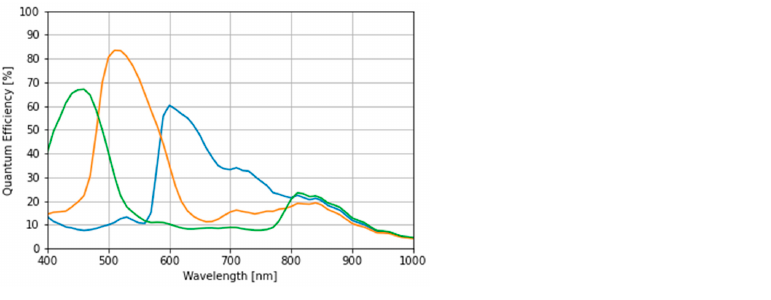
Figure 8. The quantum efficiency of complementary metal oxide semiconductor-based red–green– blue camera: AR1335. blue camera: